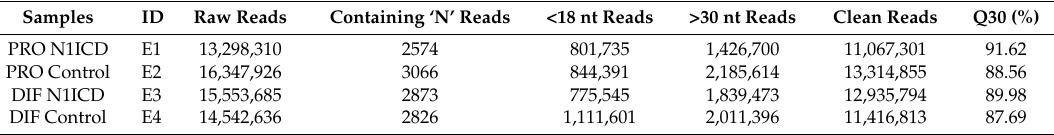
Table 2. miRNA expression profile data